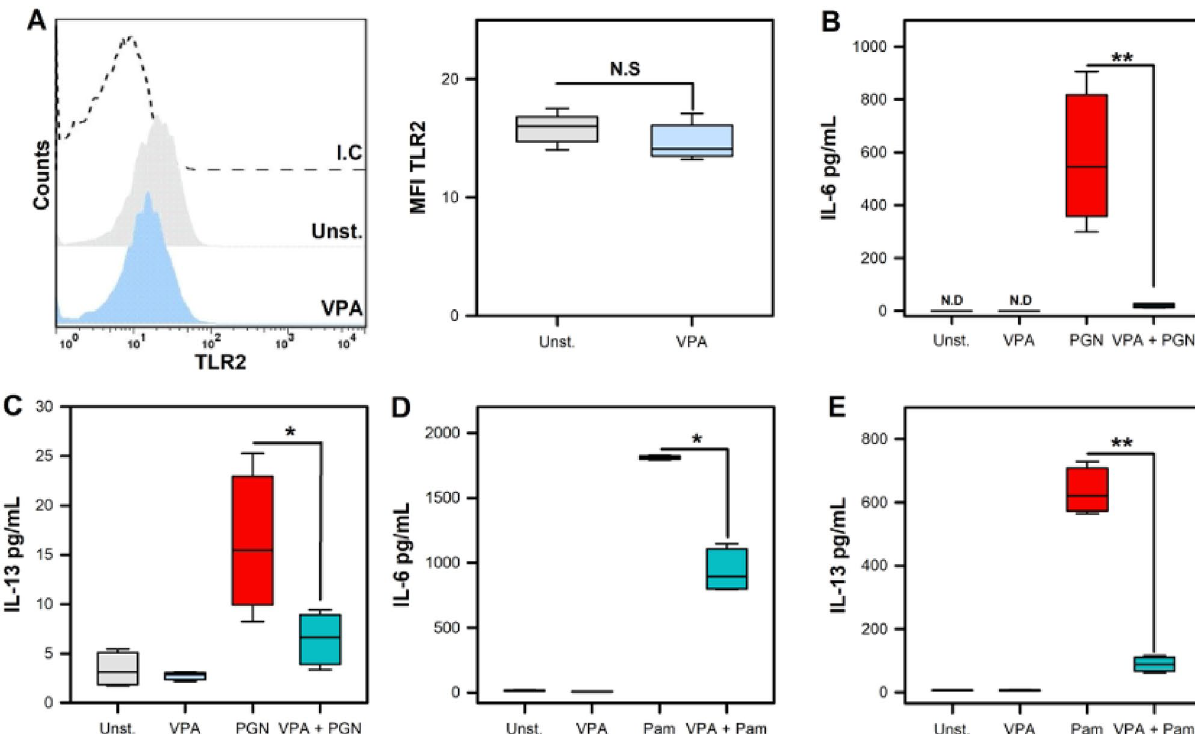
Figure 2. Valproic acid affects mast cell activation by TLR2 ligands. ( A ) BMMC were pre-incubated with 2 mM VPA for 18 h. Then, the cells were marked with anti-TLR2-biotin or biotinylated isotype control (I.C) and stained with streptavidin-APC. Staining was evaluated by flow cytometry. The left panel shows representative histograms for surface TLR2 expression. The right panel shows the median fluorescence intensity (MFI) with respect to unstimulated BMMC. (n = 4 per group; N.S = Not Significance; Mann–Whitney test). ( B , C ) BMMC were pre-incubated with 2 mM VPA for 18 h and then stimulated with S. aureus Peptidoglycan (PGN). Cytokine levels were evaluated in culture supernatants by ELISA. ( B ) IL-6 and (C) IL-13. ( D - E ) BMMC were pre- incubated with 2 mM VPA for 18 h and then stimulated with Pam3CSK4 (Pam) for 24 h. ( D ) IL-6 and ( E ) IL-13. (n = 4 per group; * p < 0.05, ** p < 0.01; Kruskal–Wallis